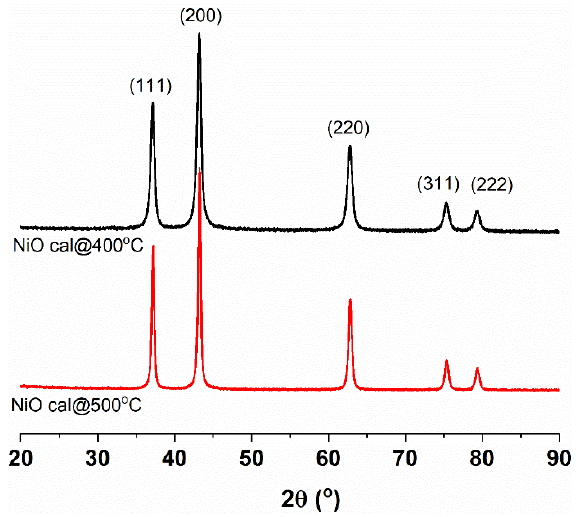
Figure 2. XRD patterns of NiO as-prepared materials calcined at 400 °C and 500 °C.